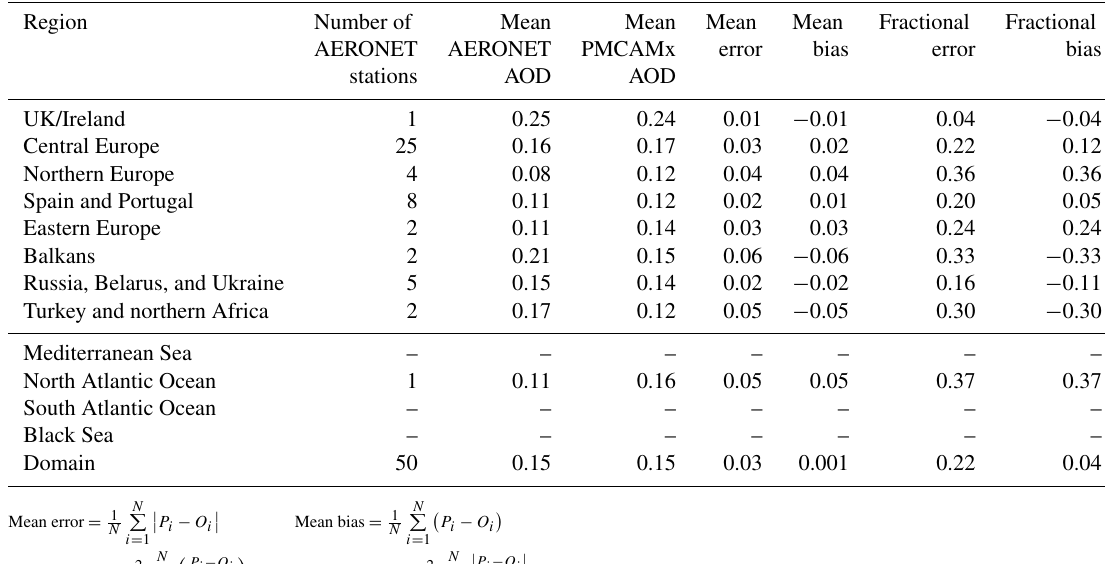
Table 1. Error metrics for the evaluation of PMCAMx against AERONET monthly mean AODs. Region